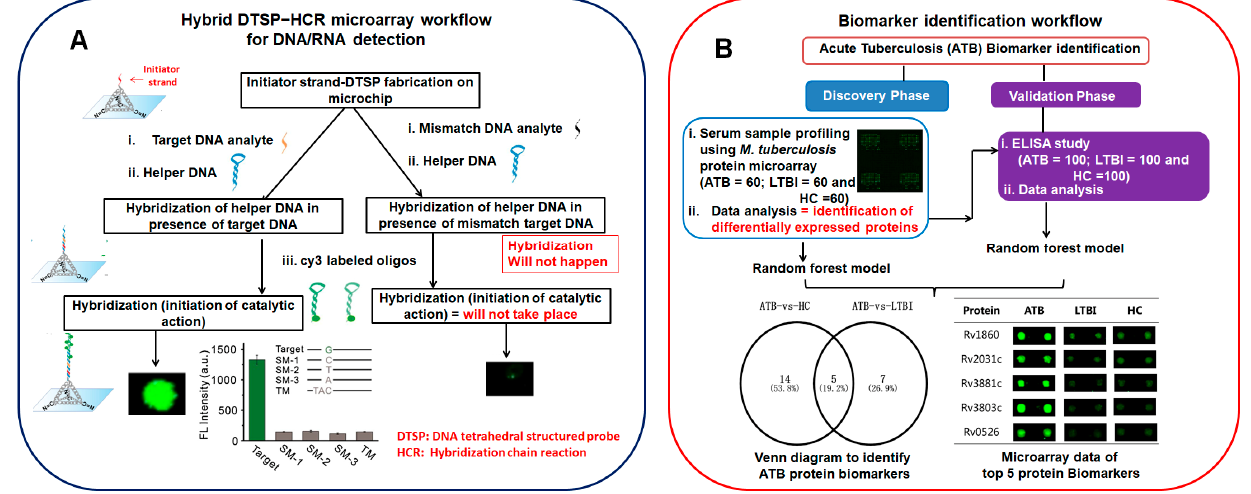
Figure 3. ( A ) A pictorial workflow presentation of hybrid tetrahedral DNA structured probe in conjugation with hybridization chain reaction (DTSP-HCR) concept used to distinguish single-base mismatches in DNA ([89]) and ( B ) an overview of acute tuberculosis (ATB) biomarker identification using a two-phase strategy (discovery phase and validation phase) ([149]). Venn diagram and microarray chip visual analysis revealed the potential of 5 protein biomarkers to distinguish ATB and LTBI/HC. LTBI represents latent tuberculosis infection, and HC represents healthy control.